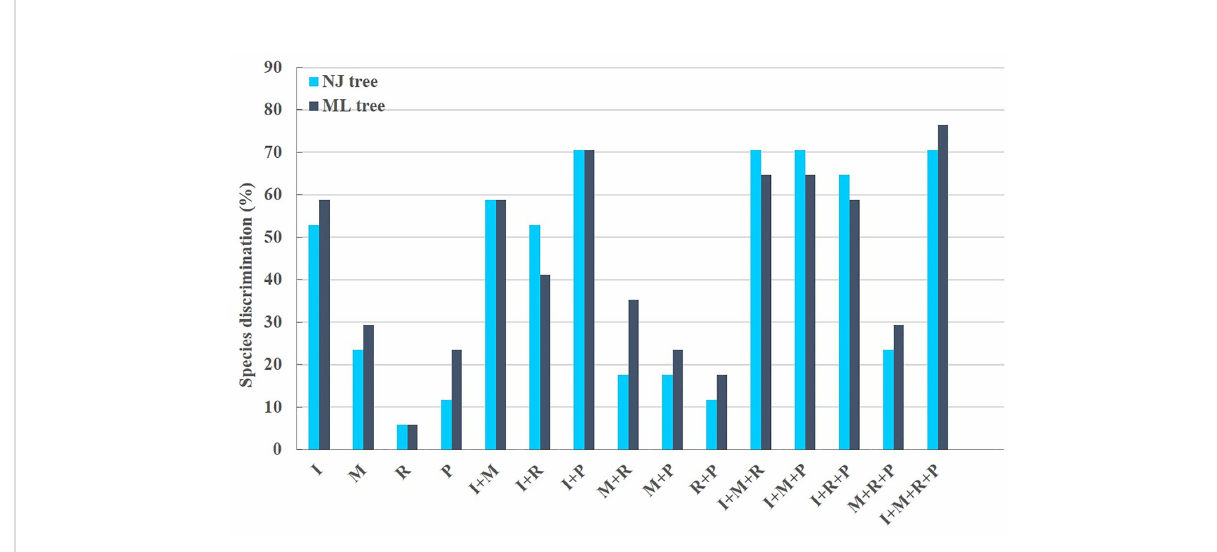
FIGURE 3 Aegilops species discrimination rates of maximum likelihood (ML) tree and neighbor-joining (NJ) tree in each candidate DNA barcode region. R, rbc L; M, mat K; P, psb M- pet N; and I, ITS2. Light blue and dark blue represent the Aegilops species discrimination rate of NJ tree and ML tree, respectively.